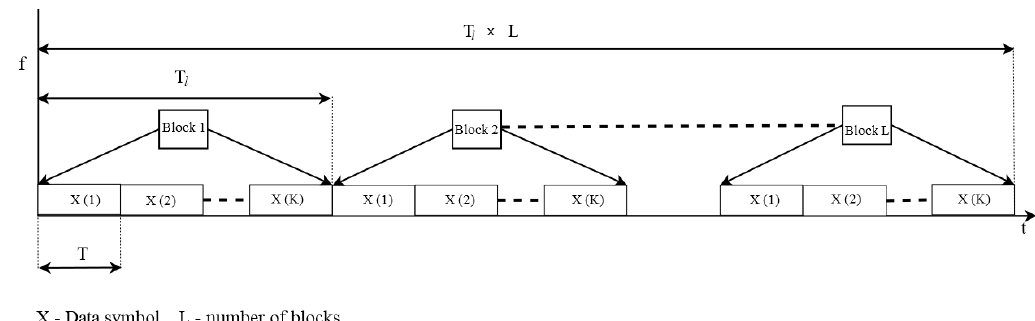
Figure 2. Frame structure of the proposed system, where T and T l are time duration of a symbol and a block, respectively.